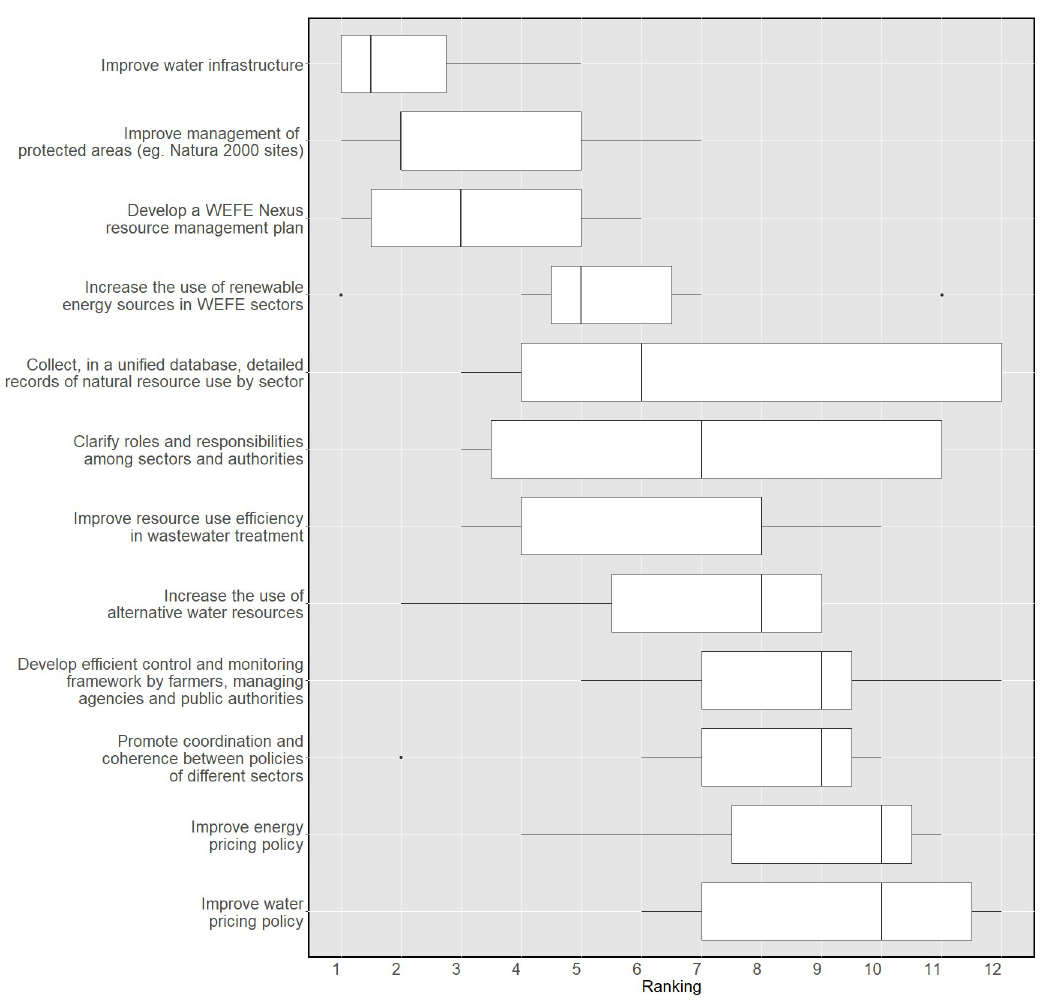
Fig 7. Prioritisation of socio-economic and technical responses. Experts’ ranking on a scale from 1 to 12 (KW: